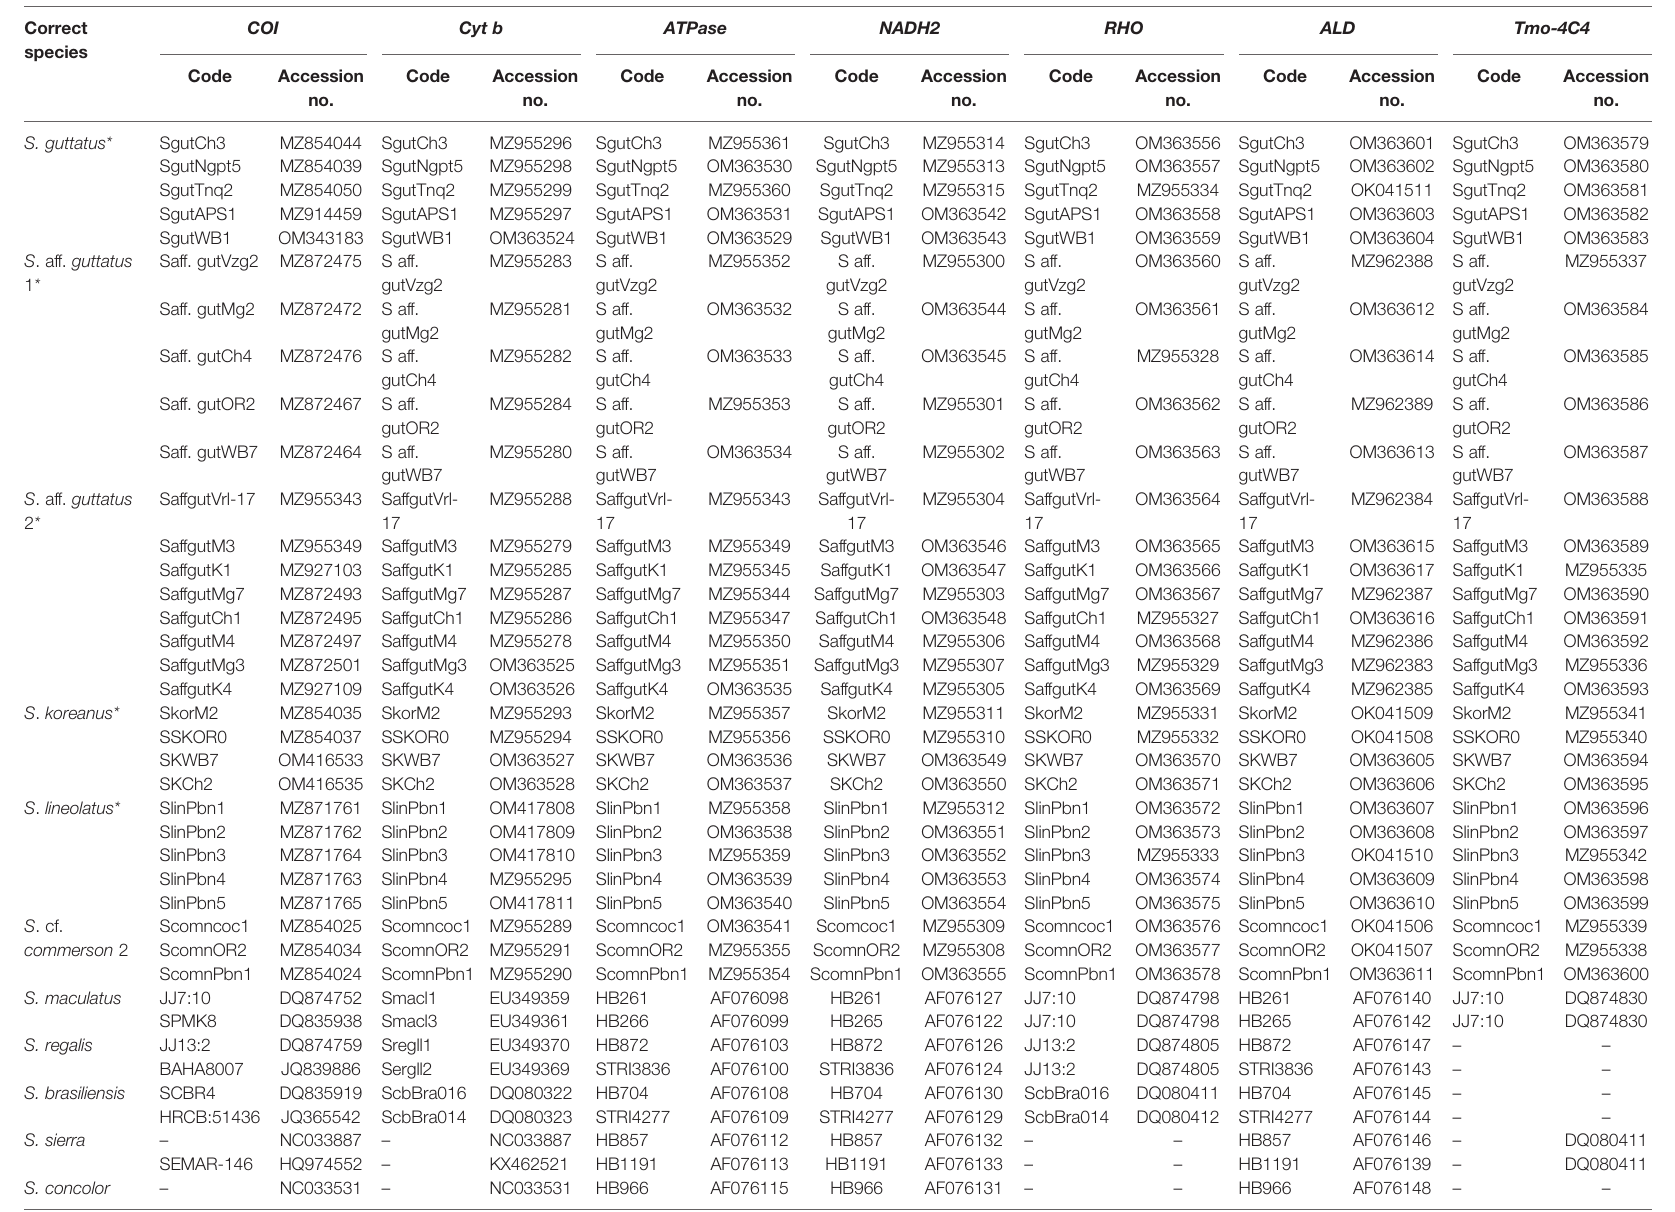
TABLE 4 | Code to Scomberomorus spp. individuals sequenced and accession numbers from GenBank generated in this study used for multilocus phylogenetic analysis are exhibited. Correct